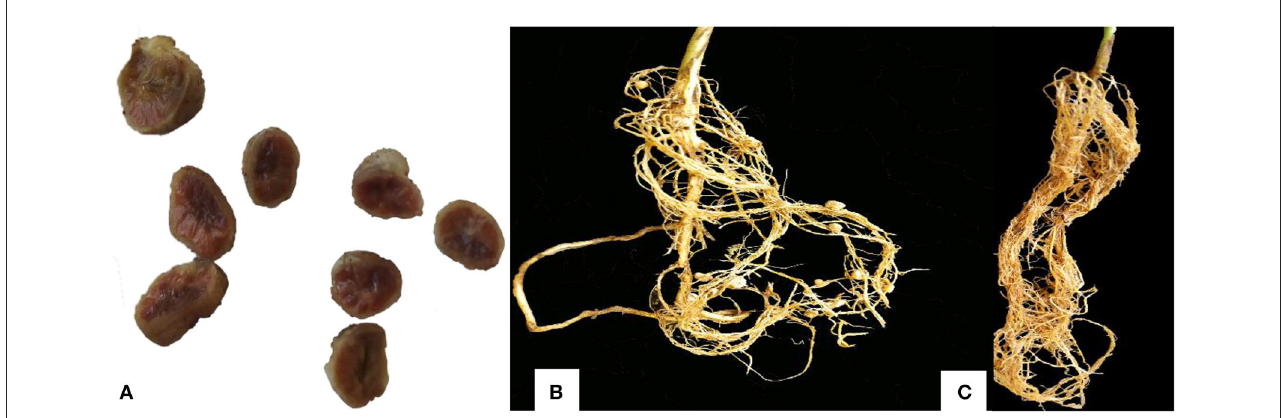
FIGURE5 Effective soybean nodules and the root form of inoculated and un-inoculated plants [ (A) Effective nodules, (B) root of inoculated plant having nodules, (C) root of un-inoculated plant, which did not form nodules].